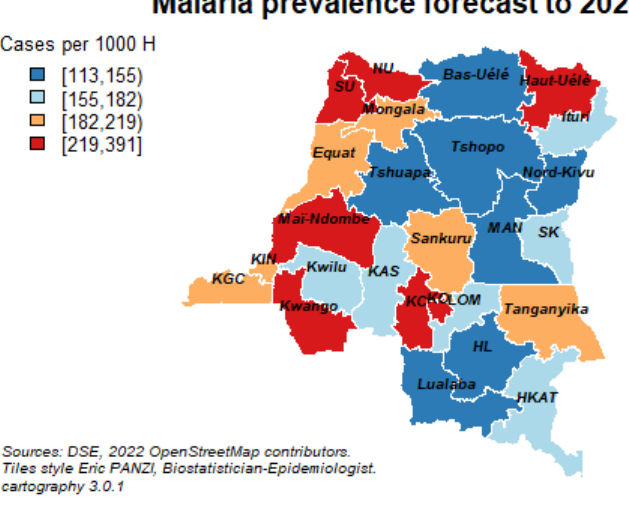
Figure A1. Malaria prevalence forecasts to 2020.